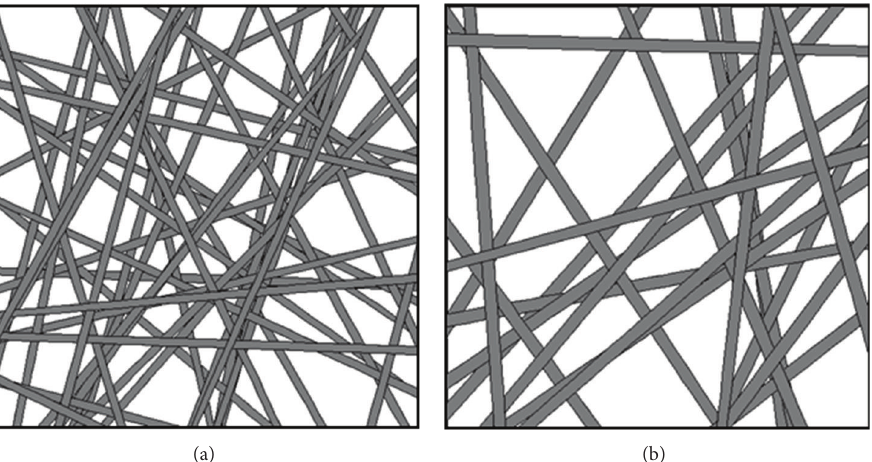
Figure 5: The comparison of simulated structures for N6-30 (size around 100nm) and N6-35 (size around 150 nm) at the same solid volume fraction.